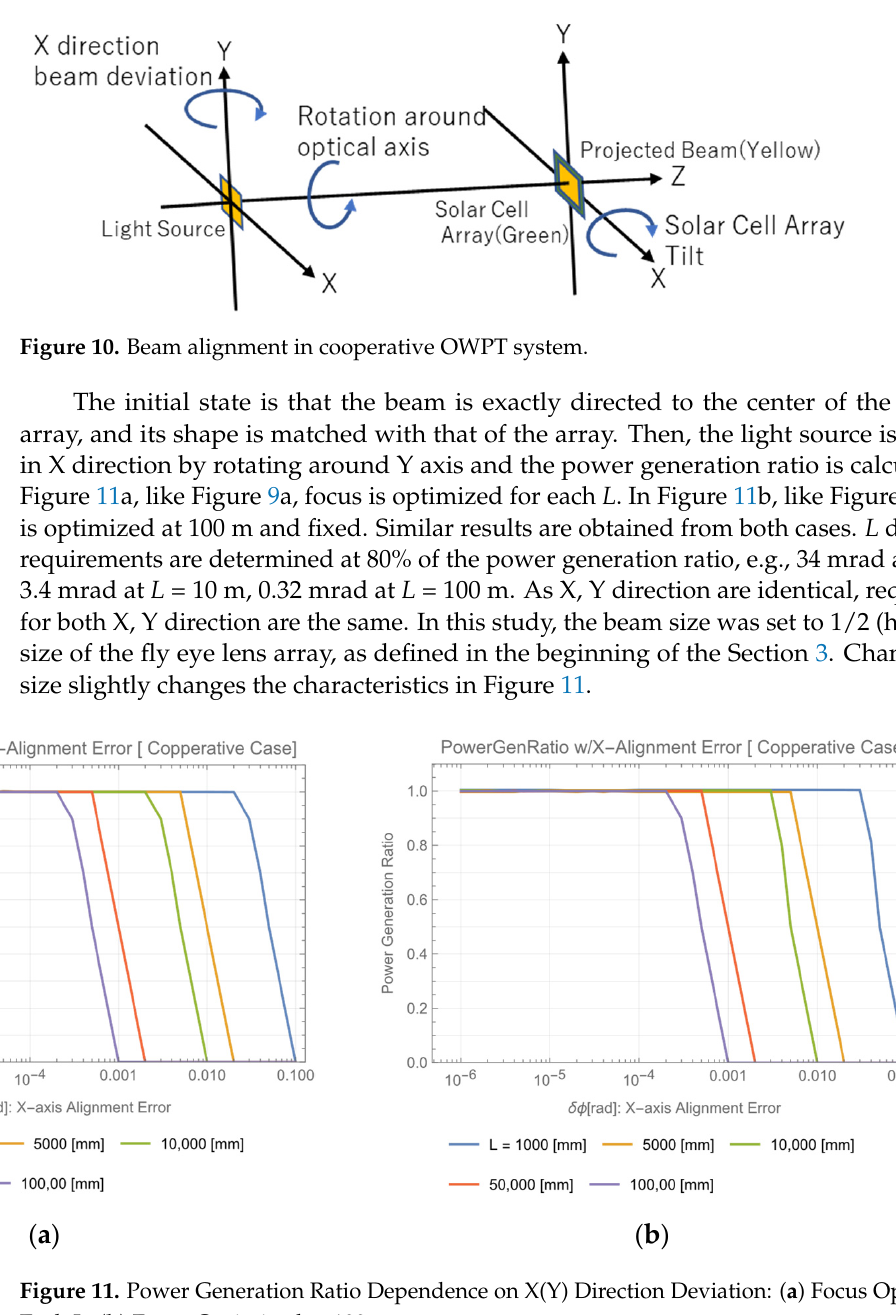
Figure 11. Power Generation Ratio Dependence on X(Y) Direction Deviation: ( a ) Focus Optimized at Each L; ( b ) Focus Optimized at 100 m.